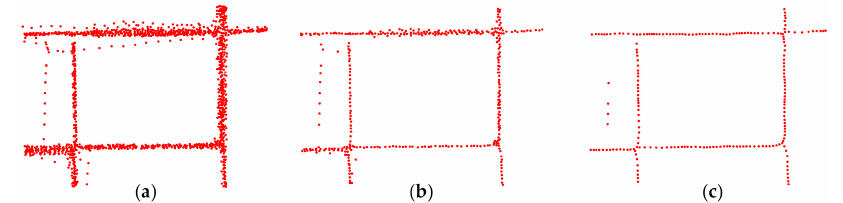
Figure 1. Iterative calculation process and calculation results; the source point is the same as in Figure 1; ( a ) Calculated results after one iteration; ( b ) results after five iterations; and ( c ) results after 20 iterations.